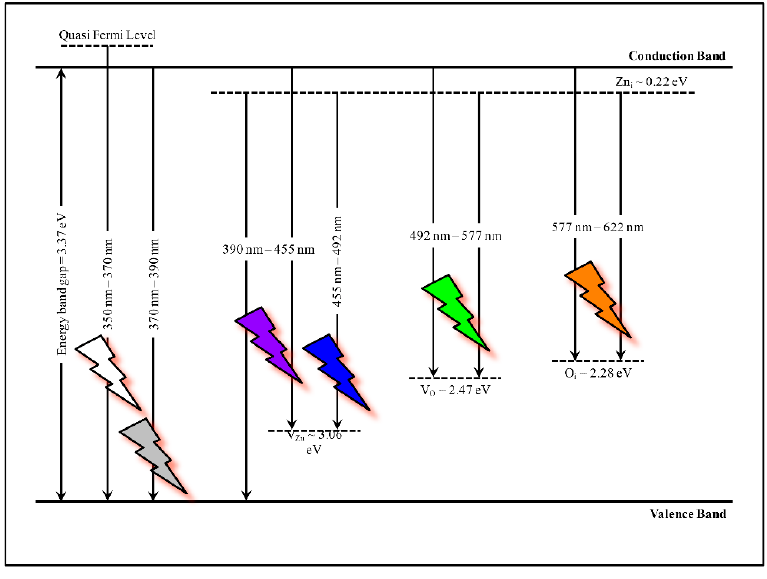
Figure 10. Schematic energy level diagram of various defect level emissions in ZnO.